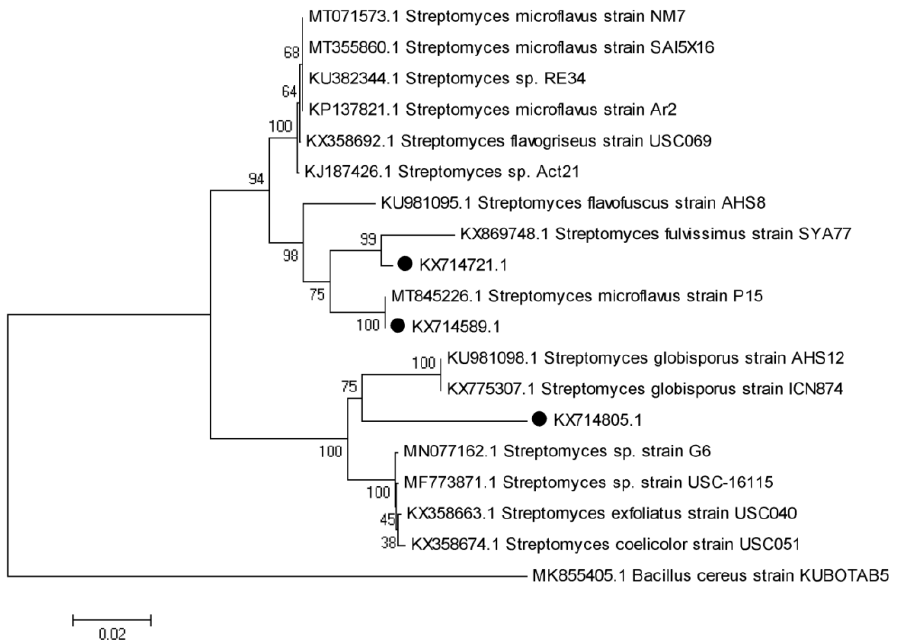
Figure 11. Phylogeny of Streptomyces isolates. BLAST search for the three isolates indicated 100% homology for isolate No. 5 as Streptomyces microflavus and isolate Gas Streptomyces somaliensis, and isolate U showed 99% homology with Streptomyces fulvissimus .